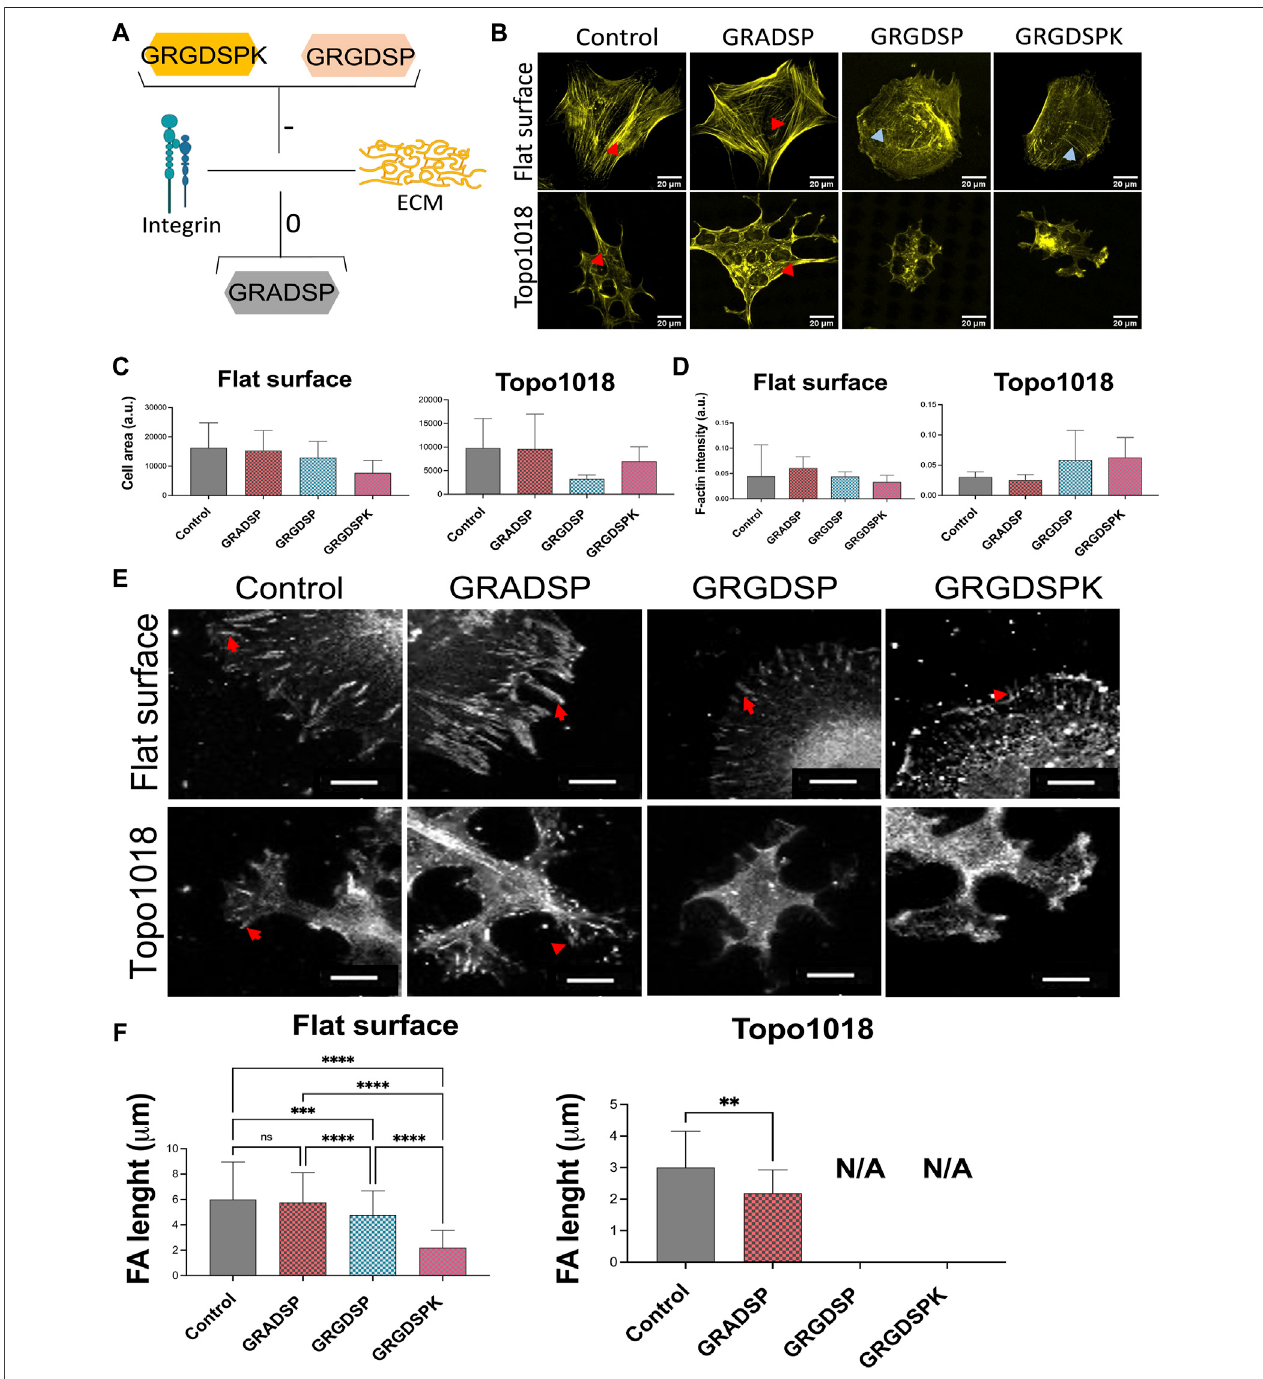
FIGURE 6 | Interfering with integrin-mediated cell adhesion via RGD peptides leads to changes in stress fi bers and focal adhesion length. (A) Illustration of the action mechanism of the peptides used in this study: Gly-Arg-Gly-Asp-Ser-Pro-Lys (GRGDSPK) and Gly-Arg-Gly-Asp-Ser-Pro (GRGDSP) to inhibit integrin-mediated celladhesionandusedGly-Arg-Ala-Asp-Ser-Pro(GRADSP)asanegativecontrol.[ (B) -Toppanel]Ona fl atsurface,controlandGRADSPtreatmentresultedinsimilarcell shape and stress fi ber appearance. GRGDSPK and GRGDSP treatments altered the stress fi ber pattern to a more dorsal stress fi ber appearance. Scale bars represent 20 µM. [ (B) -Bottom panel] On the Topo1018 surface, we observed changes in cell shape and stress fi ber structure. Scale bars represent 20 µM. Blue arrows point the dorsal stress fi bers and red arrows point the ventral stress fi bers. (C) Quanti fi cation of the cell area of cells cultured on the fl at and Topo1018 surfaces and treatedwithpeptides. (D) Quanti fi cationofF-actinintensityofcellsculturedon fl atandTopo1018surfacesandtreatedwithpeptides.[ (E) -Toppanel]Focaladhesionsof hMSCs cultured on a fl at surface (gray) are pointed with a red arrow. In control groups, the length of focal adhesions remains similar, yet GRGDSPK and GRGDSP